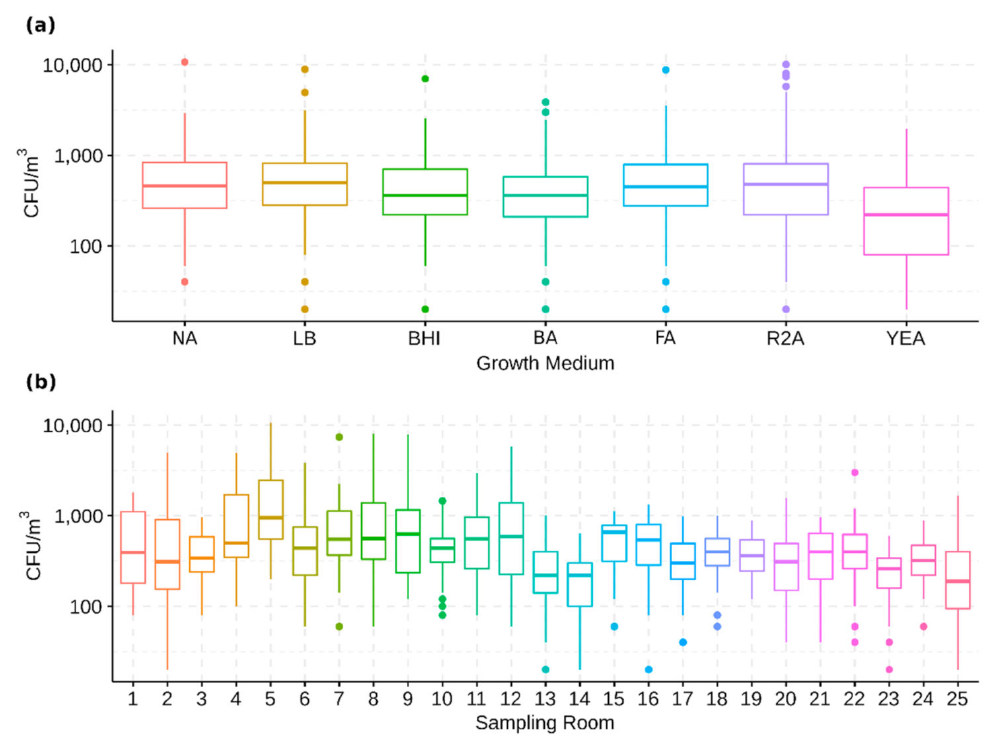
Figure 2. Box plots showing the measured CFU / m 3 distributions with a logarithmic scale. ( a ) Graph presenting the measured CFU / m 3 counts for each investigated medium. ( b ) Graph showing the CFU / m 3 counts by sampled rooms. The bold, central horizontal bars are the medians. The lower and upper limits of the box are the first and third quartiles, respectively. Points above and below the whiskers’ upper and lower bounds are outliers. NA—nutrient agar, LB—lysogeny broth, BHI—brain extract